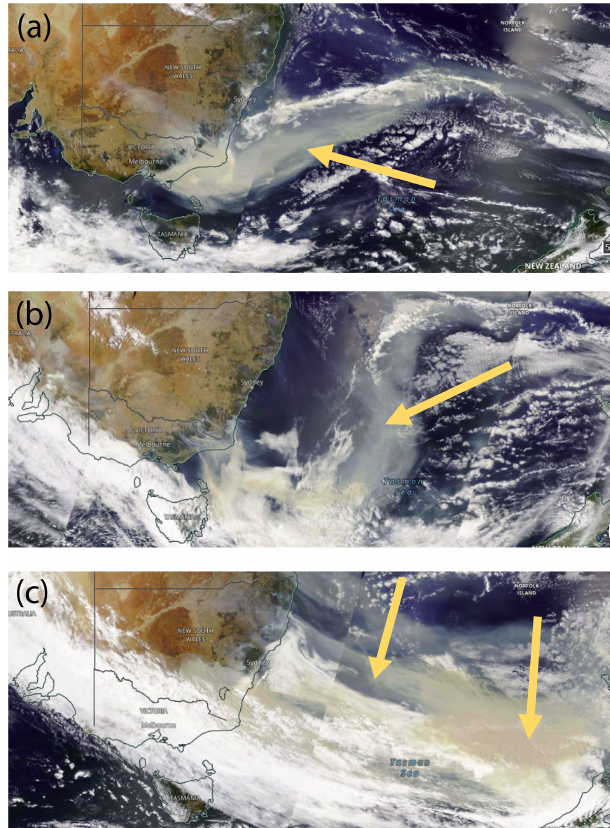
Figure 1. MODIS-visible satellite images over the Pacific between Australia and New Zealand on (a) 3 January, (b) 4 January, and (c) 5 January 2020. The smoke fields indicated by yellow arrows traveled eastward towards South